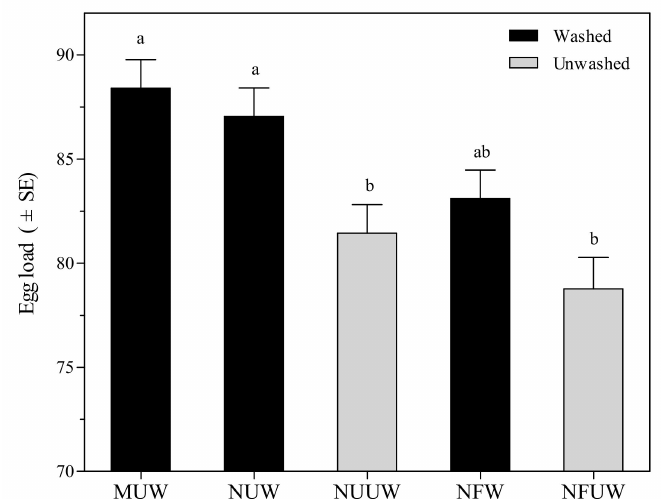
Figure 3. Egg load of Aprostocetus brevipedicellus offspring from Antheraea pernyi eggs with five treat- ments. MUW: manually-extracted, unfertilized and washed eggs; NUW: naturally-laid, unfertilized and washed eggs; NUUW: naturally-laid, unfertilized and unwashed eggs; NFW: naturally-laid, fertilized and washed eggs; NFUW: naturally-laid, fertilized and unwashed eggs. Different lower- case letters on bars indicate significant differences among egg treatments based on Tukey’s multiple comparison test (HSD) ( p <